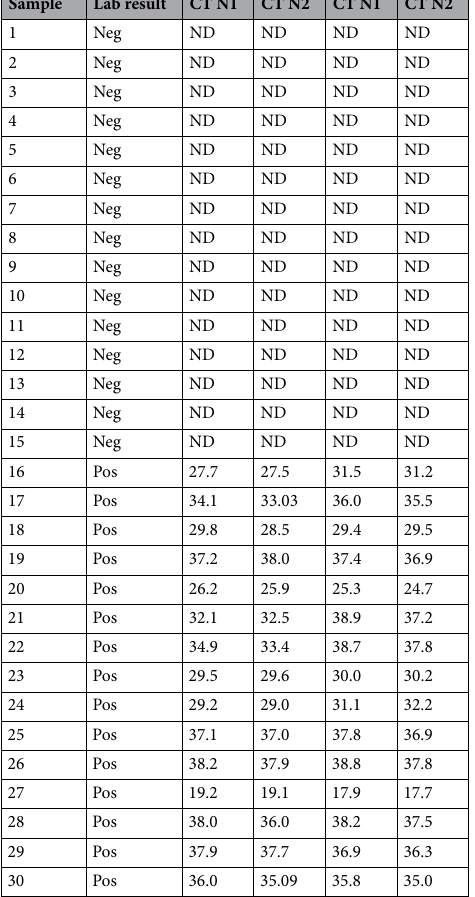
Table 3. Direct amplification of clinical samples in vLAB. Clinical samples from positive (Pos) and negative (Neg) patients were purified with QIAGEN RNA extraction kit or diluted with vLAB. The CT values from RT-PCR amplification with RNA extracted with QIAGEN and